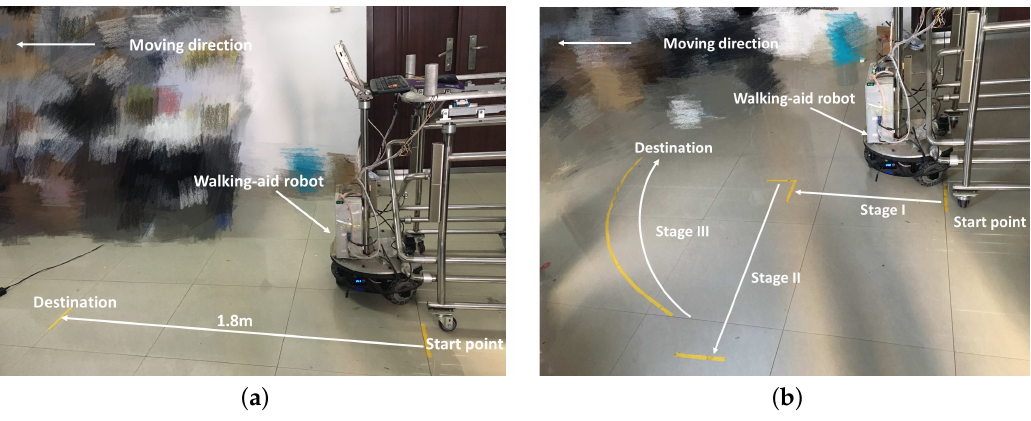
Figure 8. The two compliance control experiments. ( a ) The user goes straight with the robot. The white arrow line indicates the robot’s moving direction. ( b ) User goes straight (Stage I) → goes to the left (Stage II) → follows the curve (Stage III). The white arrow line indicates the robot’s moving